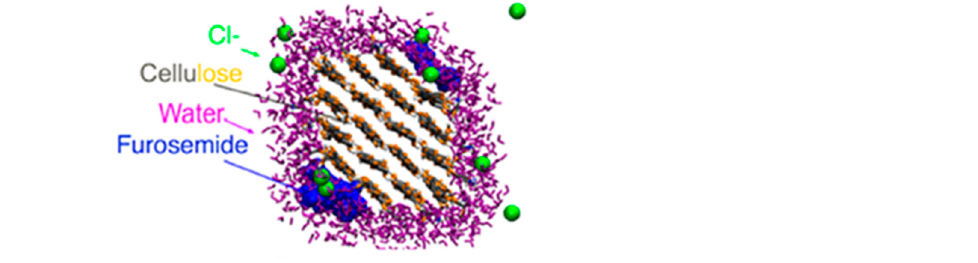
Figure 13. Snapshot of the sorption simulation of furosemide on a charged cellulose nanofiber [108].